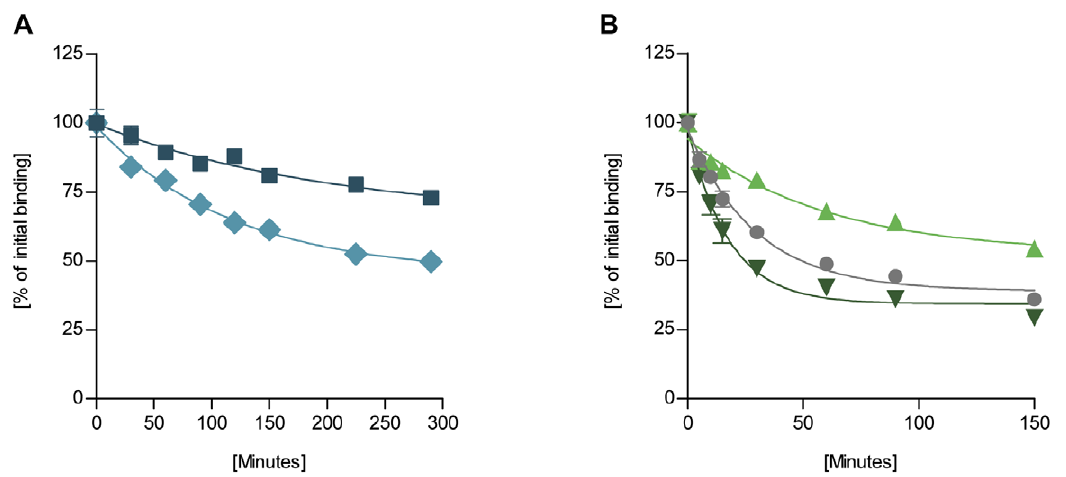
Figure 3. Representative dissociation curves of [ 125 I]-labelled insulin or analogue from BHK-hIR cells. Dissociation was measured at N different time points and the residual binding expressed as a percentage of initial binding. Dissociation of ( A ) B10D ( ¤ ) and B10E ( & ); ( B ) B10W ( m ), ), and B10R ( . ). Data points are means 6 SEM (n=3). human insulin (